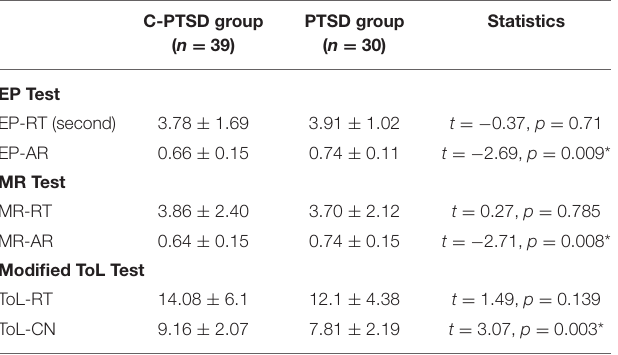
TABLE 3 | Comparison of neurocognitive functions between the complex and non-complex PTSD groups. C-PTSD group ( n = 39)